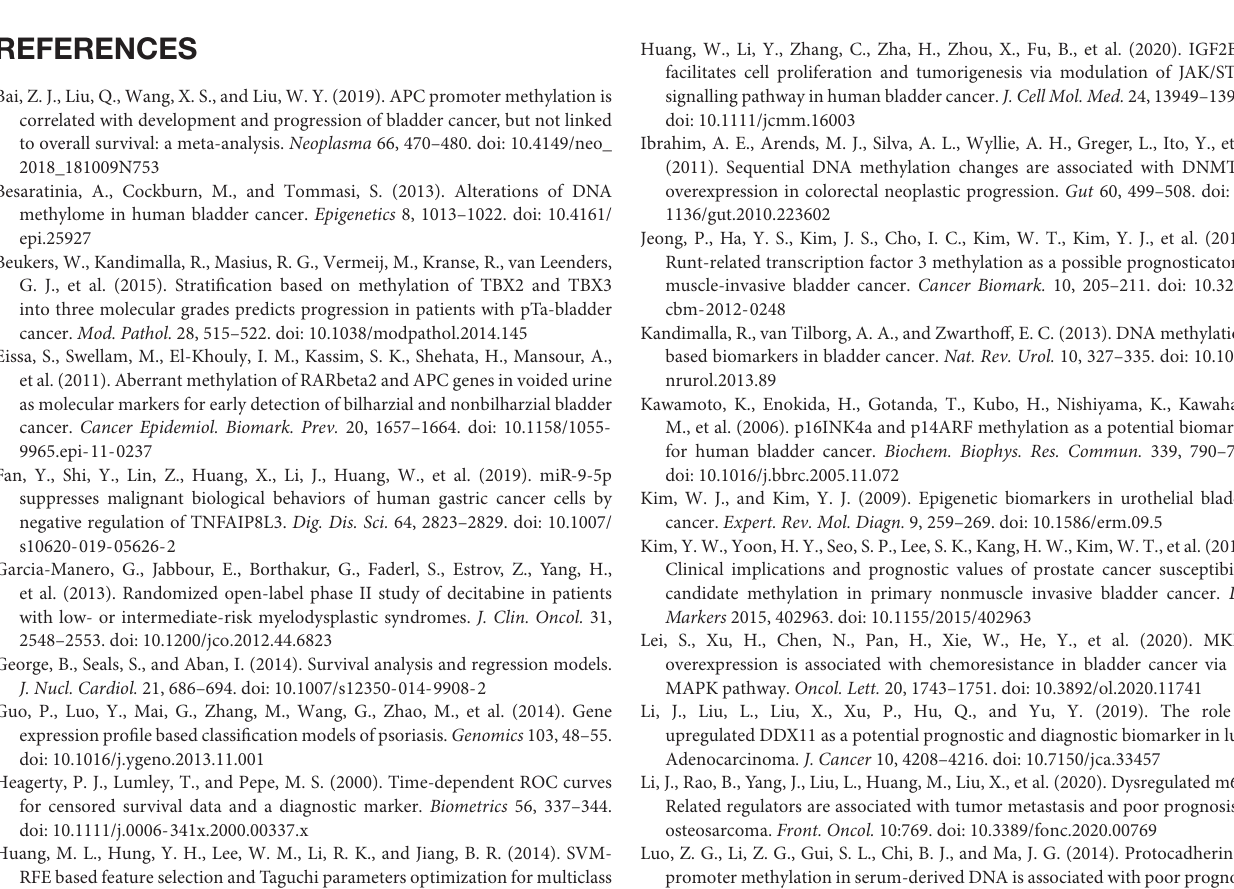
Supplementary Figure 2 | The nomograms for overall survival based on the MRSB. Supplementary Figure 3 | The nomograms for recurrence-free survival based on the MRSB. Supplementary Figure 4 | The expression of the MRSB component-related genes was associated with the prognosis in BLCA patients. (A) Performance of the MRSB in PFS. (B) Performance of the MRSB in OS. Supplementary Table 1 | One hundred thirty CpGs were identified by the SVM-RFE algorithm. Supplementary Table 2 | Fifteen CpGs that appeared more than 500 times in 1,000 iterations and were considered consensus CpGs that distinguished high- from low-risk groups were identified by the iterative LASSO